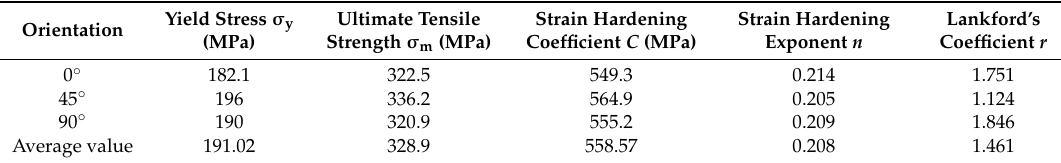
Table 1. Mechanical properties of the tested